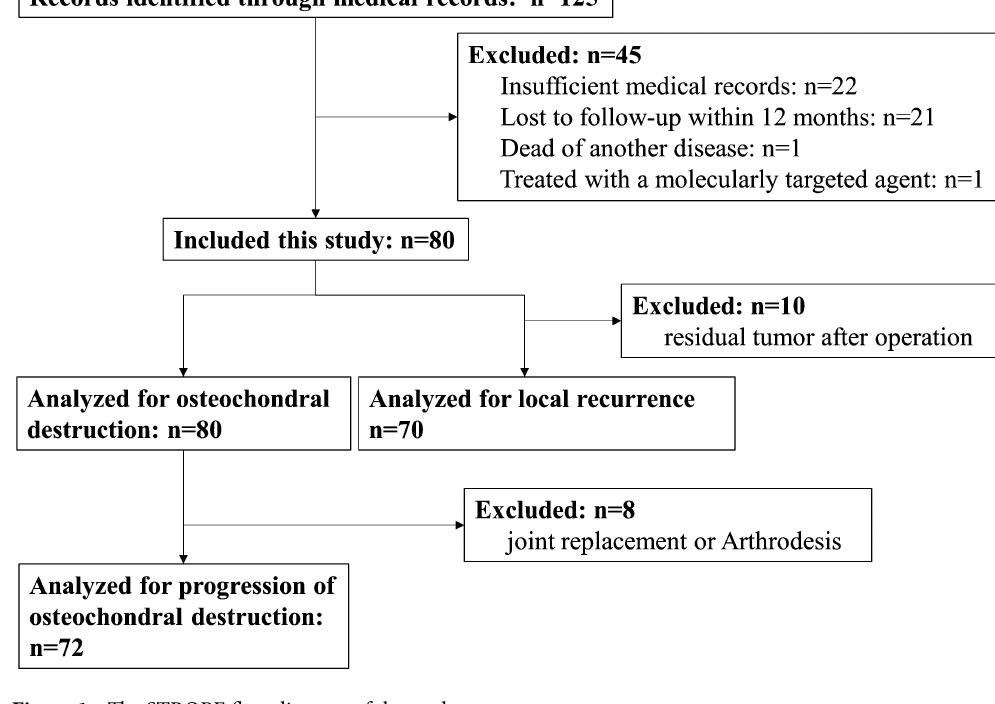
Figure 1. The STROBE flow diagram of the